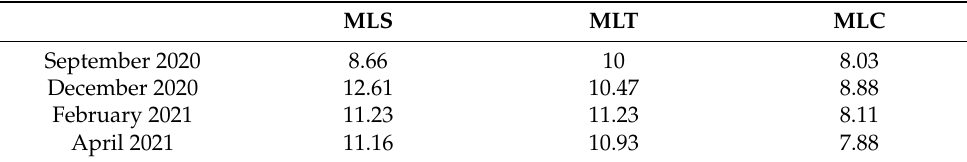
Table 3. Narration